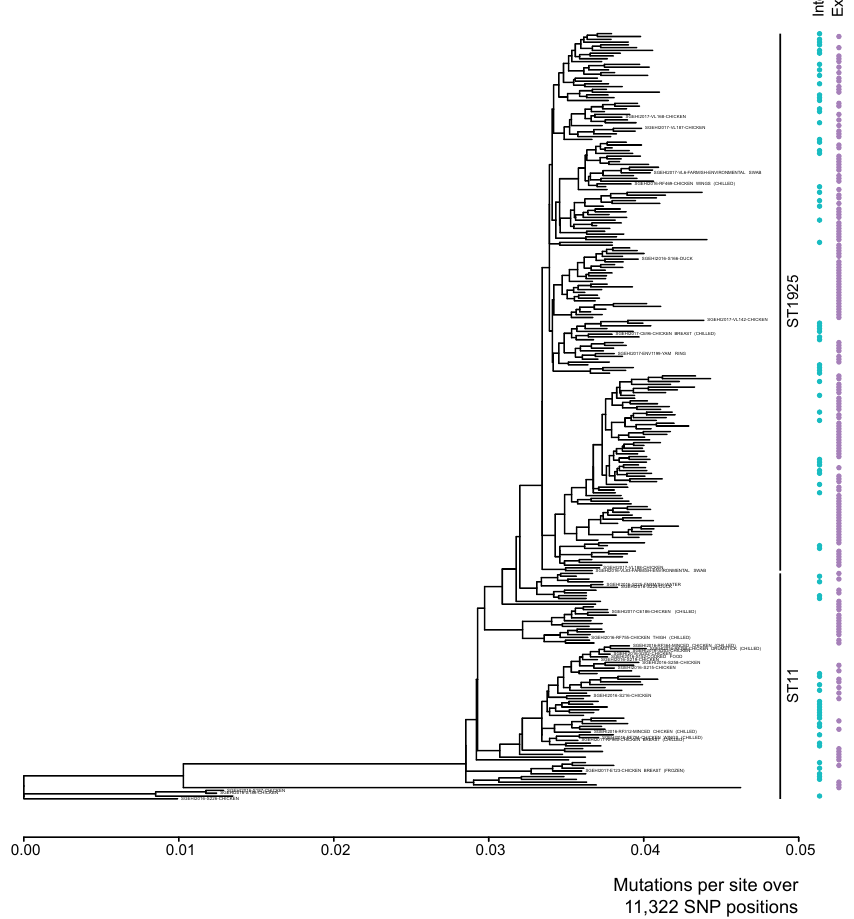
Figure 4. Maximum-likelihood SNP trees of 276 S . Enteritidis isolates. Food, and farm/slaughter house environment isolates were labelled on the tree, whereas non-labelled isolates were human